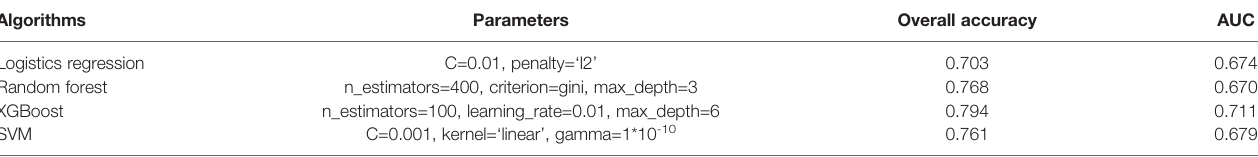
TABLE 3 | Parameters and performance of machine learning algorithms. Algorithms